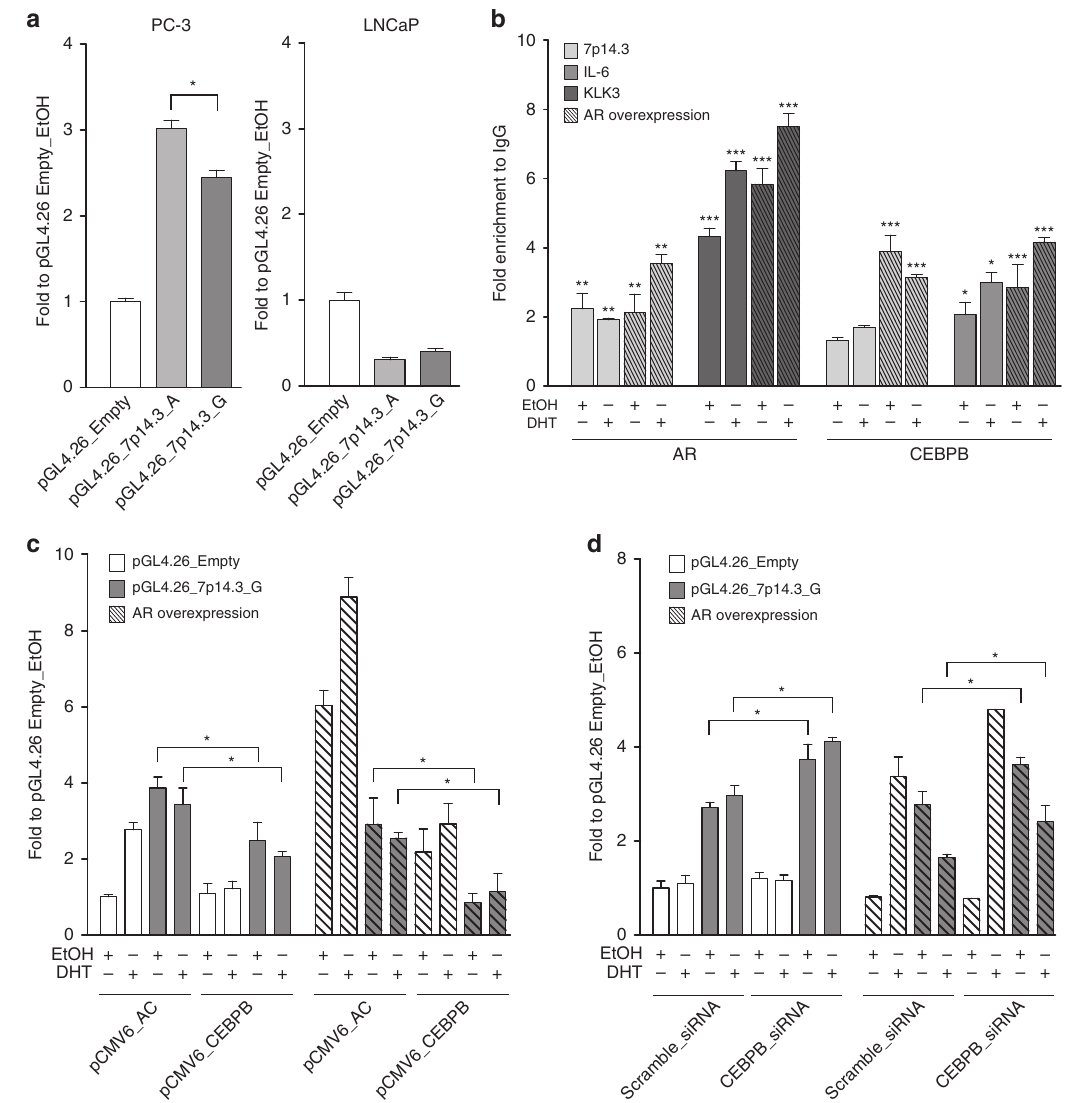
Fig. 2 Functional characterization of 7p14.3 variant. a Luciferase assays were performed on PC-3 and LNCaP cells transfected with pGL4.26 vectors containing 7p14.3 (A or G allele, represented in light grey and dark grey , respectively) or empty vector ( white ); mean ± s.d. of three biological replicates. b PC-3 cells were transfected with pCMV_Empty ( solid bars ) or pCMV_AR ( dashed bars ) vectors; AR ( left ) or CEBPB ( right ) chromatin binding at 7p14.3 locus in PC-3 cells were evaluated by ChIP-qPCR. Occupancy level at KLK3 enhancer and IL-6 promoter was used as positive control of AR and CEBPB, respectively. Data are represented as mean ± s.d. of two biological replicates. c Luciferase assays on PC-3 cells co-transfected with pCMV6_CEBPB and/or CMV_AR ( dashed bars ) along with the different pGL4.26 reporter vectors described above. The enhancer activity is inhibited upon CEBPB overexpression. The inhibition becomes stronger upon AR over-expression. Data are represented as mean ± s.d. of two biological replicates. d Luciferase assays on PC-3 cells transfected with siRNA against CEBPB or scrambled siRNA. Then, cells were co-transfected with pCMV_Empty or pCMV_AR vectors along with the pGL4.26 reporter vectors described above. Data are represented as mean ± s.d. of two biological replicates. Where indicated, cells were treated for 16 h with EtOH or DHT. * P < 0.05,.** P < 0.01, *** P < 0.005, Student ’ s t -test